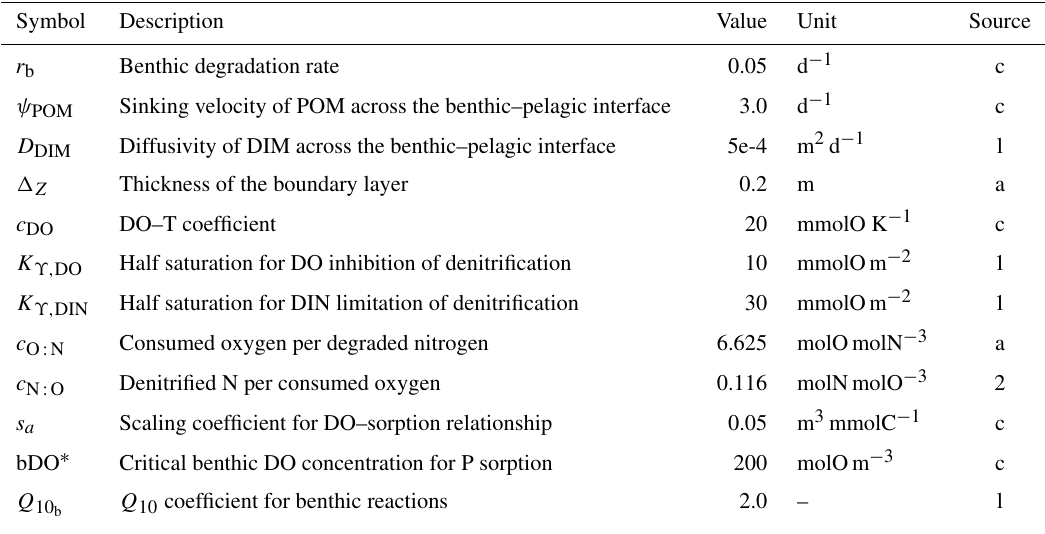
Table A5. Parameters of the benthic module. Codes for sources: c – calibrated; a – assumed; l – typical literature value; (1) Soetaert et al. (1996); (2) Seitzinger and Giblin